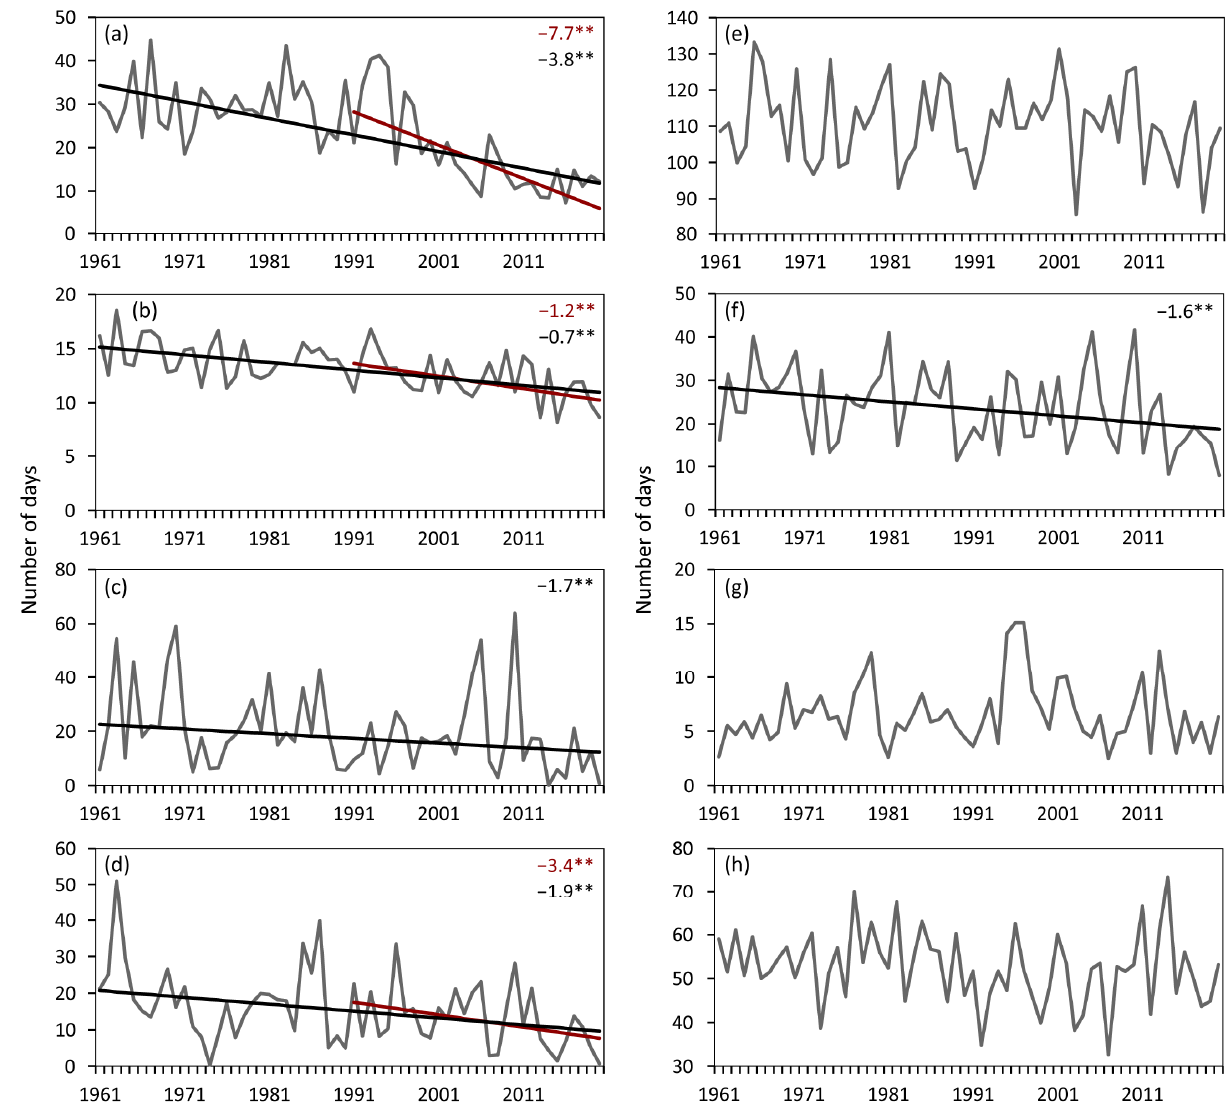
Figure 9. Fluctuations in mean annual numbers of days with selected climate variables in the Czech Republic and their statistically significant linear trends (top right in days/10 years; ** statistically significant for p < 0.05) in the 1991–2020 and 1961–2020 periods. ( a ) Days with wind gusts ≥ 20 m s − 1 ; ( b ) days with thunderstorm; ( c ) days with snow cover depth ≥ 15 cm; ( d ) days with TMIN ≤ − 10.0 ◦ C; ( e ) precipitation days with daily total ≥ 1.0 mm; ( f ) days with snowfall; ( g ) days with glaze ice; ( h ) days with